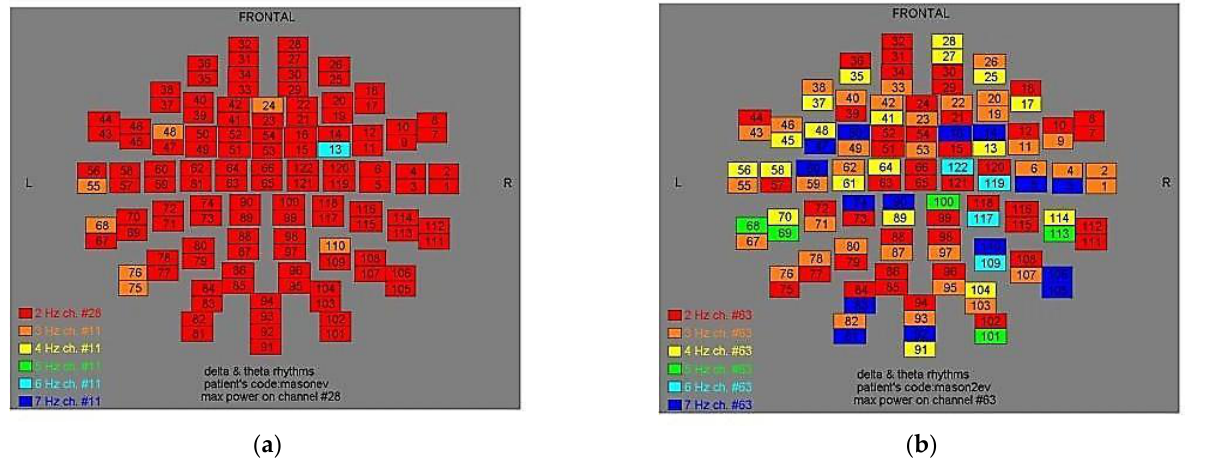
Figure 4. Dominant frequency color mapping for patient #3, before ( a ) and after ( b ) magnetic stimulation.